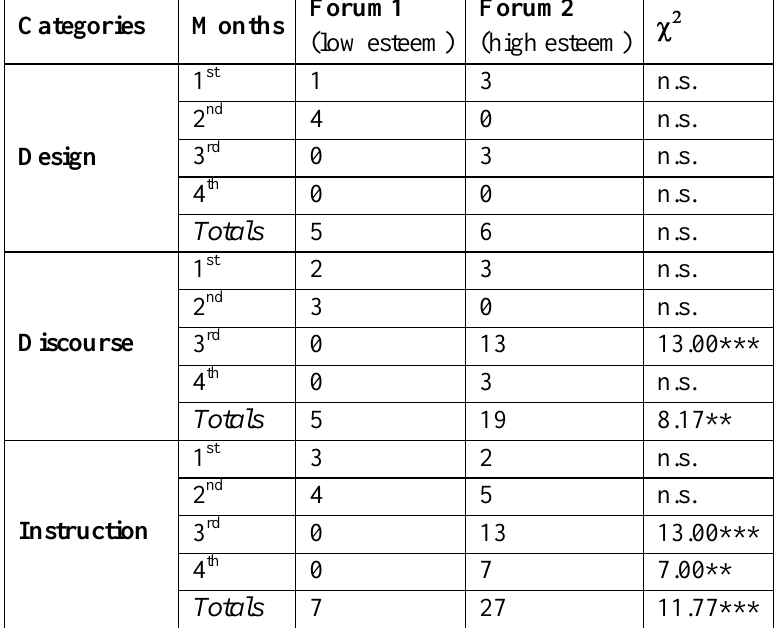
Teaching Presence: Instructors’ Postings Only Categories